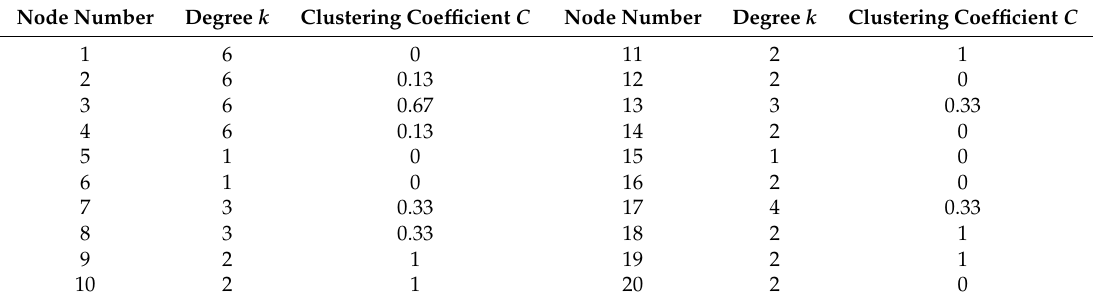
Table 1. Degree number and clustering coefficient of all